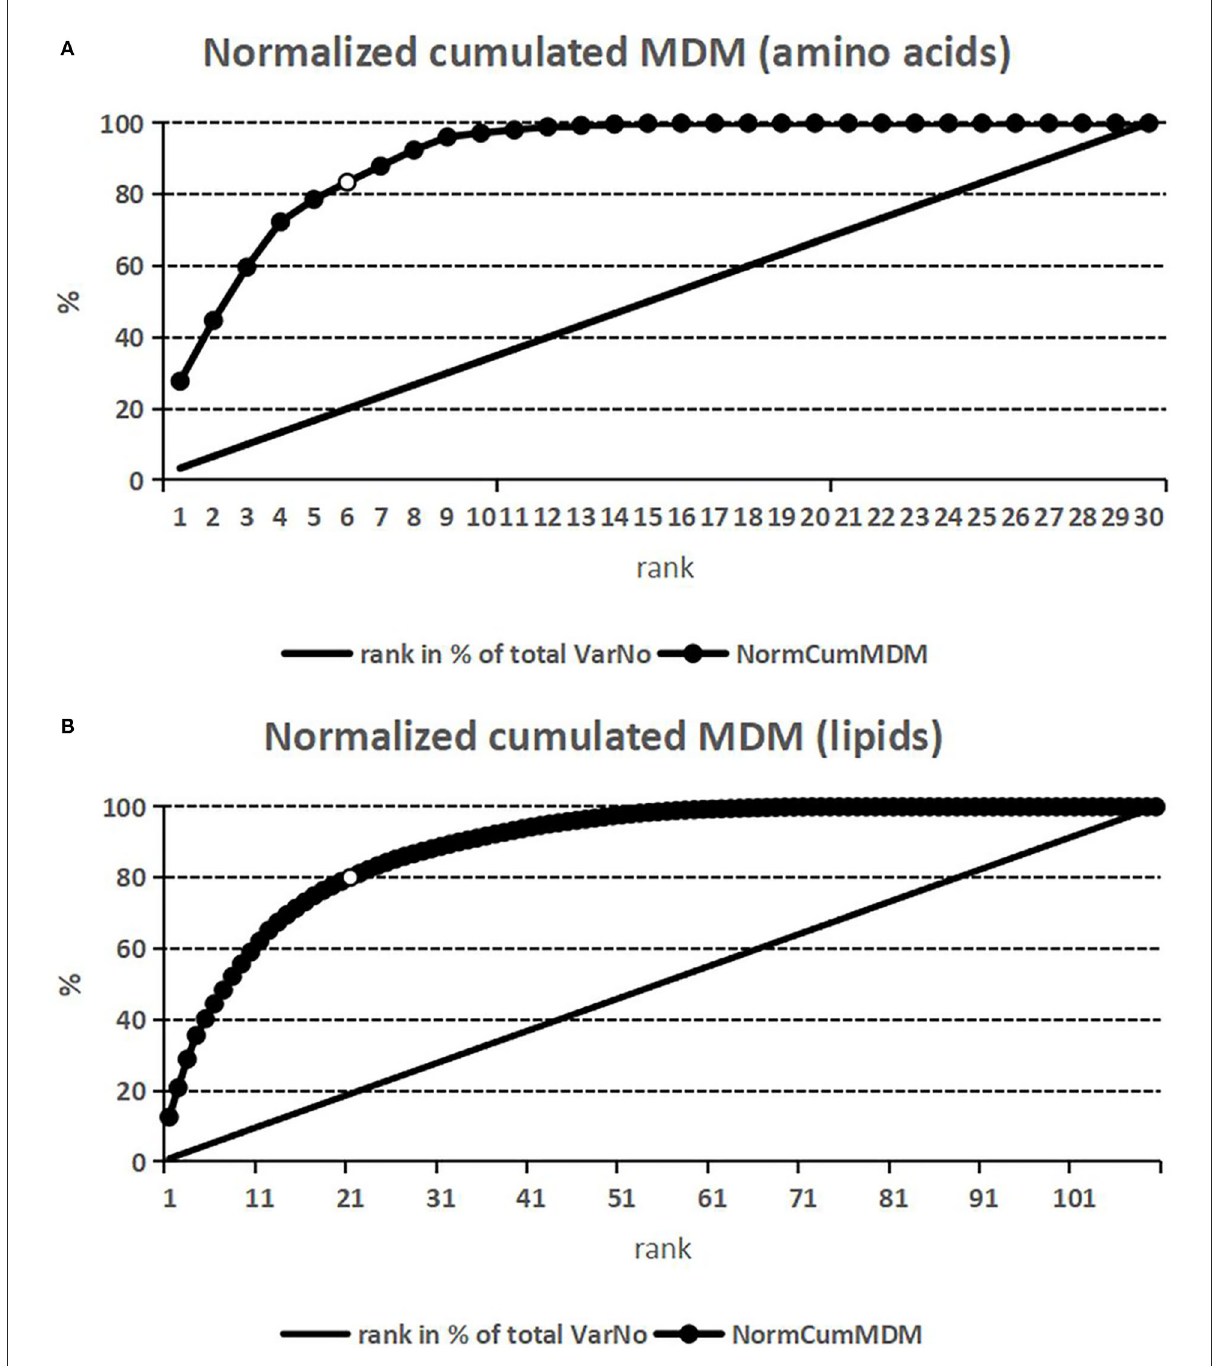
FIGURE1 Cumulative classification impact (diseased vs. non-diseased)—normalized to 100%—of the respective metabolites (dotted curves) vs. absolute impact rank. The linear line indicates the analyte’s rank normalized to 100%. %, percentage; MDM, mean decrease in the margin (variable importance with respect to classification into diseased vs. non-diseased); NormCumMDM, normalized cumulated mean decrease in the margin; rank, rank with respect to classification impact MDM, starting with the highest impact as rank 1. (A) Amino acids. The topmost ranked 6/30 amino acids (20% of analytes; open circle) account for 80% of the classification total. (B) Phospholipids. The topmost ranked 21/110 phospholipids (19% of analytes; open circle) account for 80% of the classification